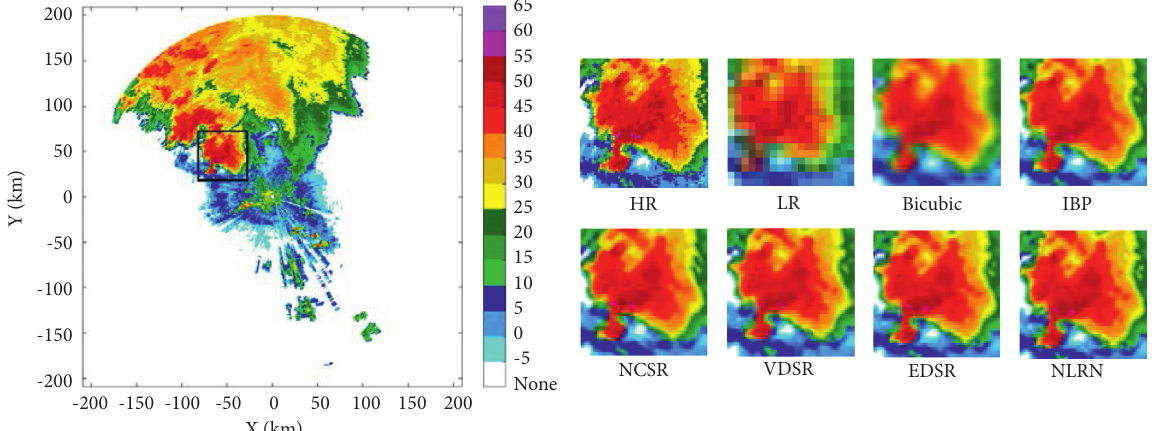
Figure 10: Visual comparison of × 4 super-resolution reconstruction results of tornado data. The best results are in bold.